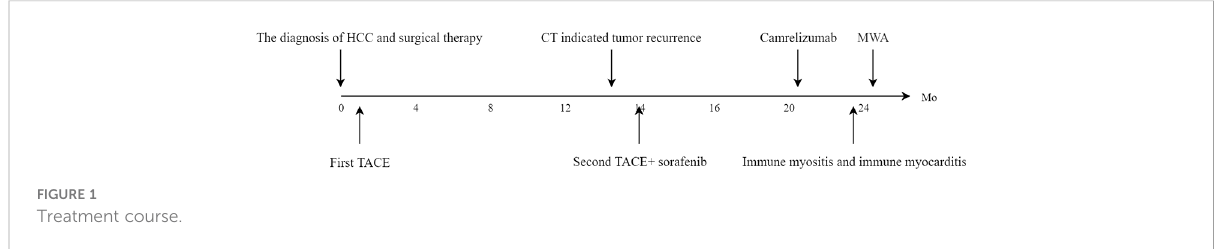
FIGURE 1 Treatment